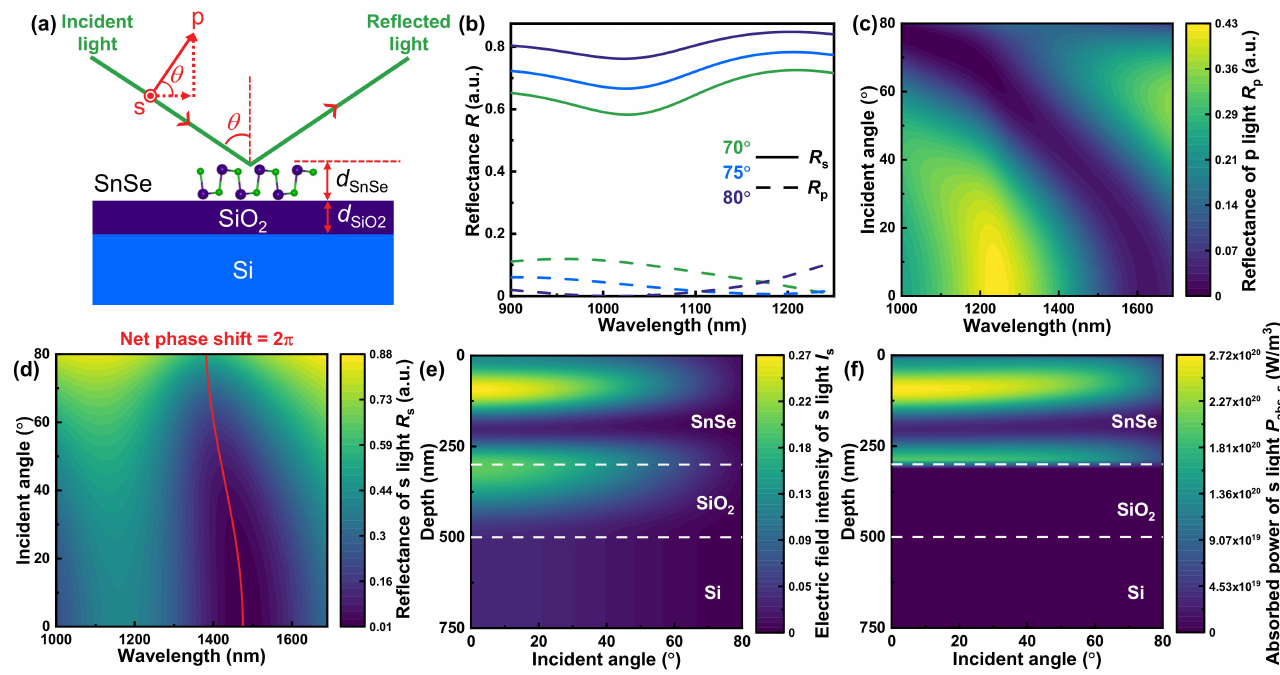
Figure 2. ( a ) SnSe-SiO 2 -Si multilayer structure with the incident angle θ . ( b ) The reflectance of s and p light at high incident angle of 70 ◦ , 75 ◦ , and 80 ◦ , where the thickness of SiO 2 ( d SiO of SnSe ( d SnSe ) are, respectively, 200 and 300 nm. The contour maps of reflectance of ( c ) p and ( d ) s light varied with the incident angle. The contour maps of s light’s ( e ) electric field intensity I s and ( f ) absorbed power P abs,s varied with the depth and the incident angle, selecting the maximum reflectance wavelength (1164 nm) at normal